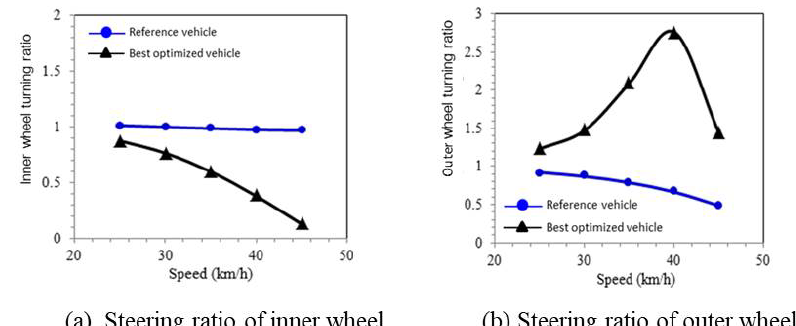
Figure 22. Simulation result of the steering ratio.